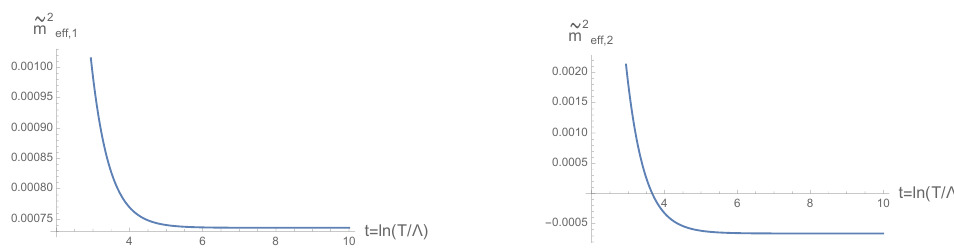
Figure 8. Plots of the rescaled effective masses (squared) against t = ln( T/ Λ) for r = 0 . 1 , θ = π , and grow as the temperature decreases. In the high λ = 0 . 001 , c 1 = 0 . 1 , c 2 = 0 : both m 2 m 2 e e eff , 1 eff , 2 temperature limit, saturates at a positive value while saturates at a negative value. m 2 m 2 e e eff , 1 eff , 2 This indicates a phase transition at an intermediate temperature where the baryon symmetry in